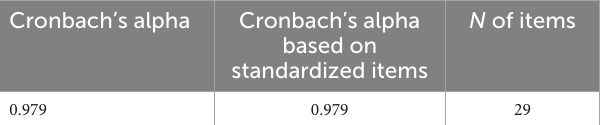
TABLE 3 Reliability